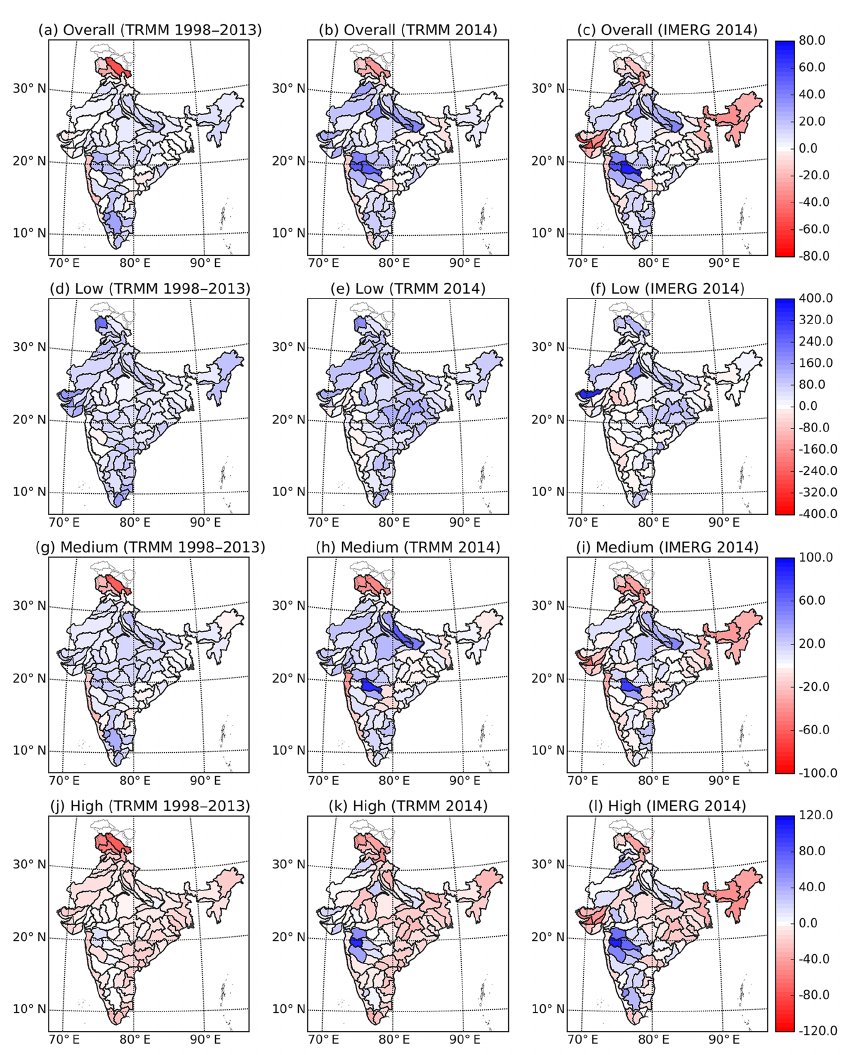
Figure 6. Spatial representation of percentage bias of TRMM 1998–2013, TRMM 2014 and IMERG 2014 over 86 delineated river basins across India for (a–c) overall time series and over (d–f) low, (g–i) medium and (j–l) high rainfall regimes.